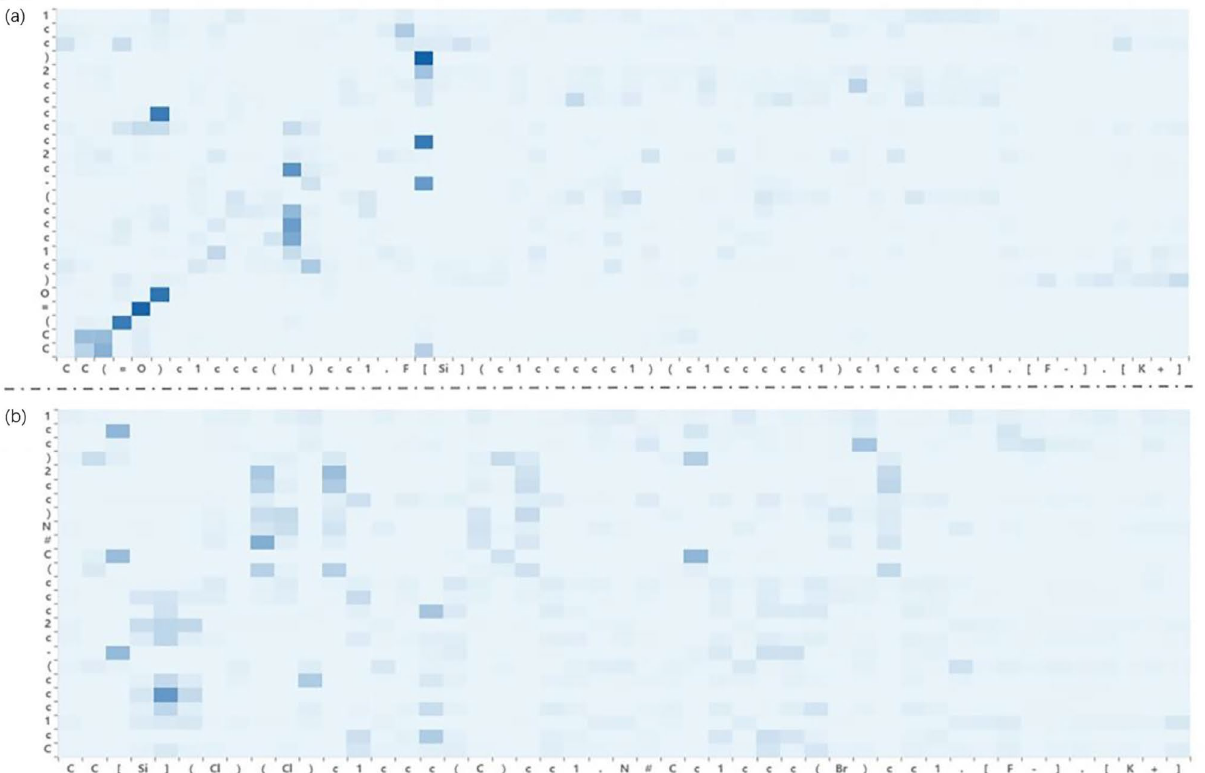
Figure 4. Visualization of attention weight before and after Hiyama reaction augmentation. The horizontal axis contains two reactants and reagents, and the vertical axis is the product. ( a ) SMILES:CC(=O)c1ccc(I)cc1.F[Si]